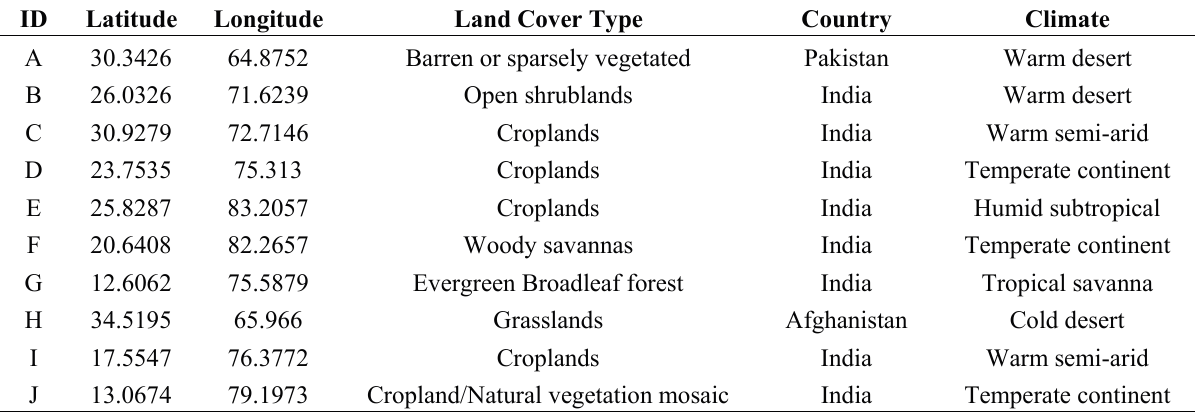
Figure 8. Land cover map of South Asia acquired from the MODIS land cover product and the locations of the selected ten sites. Table 1. Location and land cover information of sampling